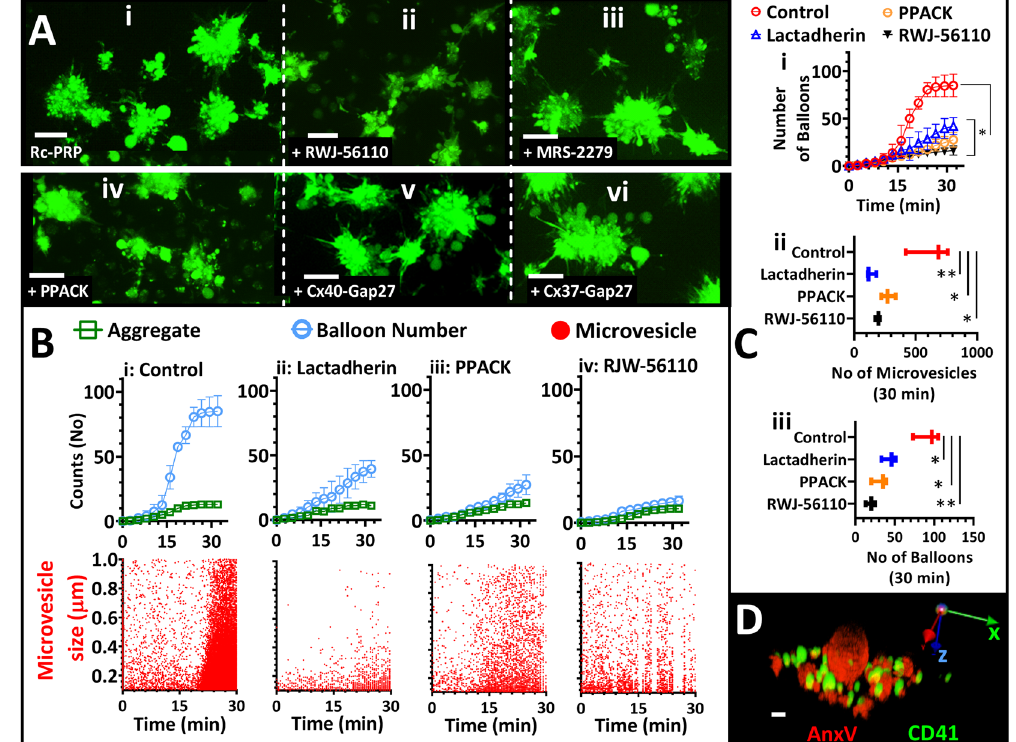
Figure 4. Thrombin-mediated synchronous ballooning is associated with a surge in microvesiculation. ( A ) Aggregate formation of Fluo-4-labelled platelets in re-calcified platelet-rich-plasma (Rc-PRP) in the absence (A-i) or presence of RWJ-56110 (A-ii), MRS-2279 (A-iii), PPACK (A-iv), Connexin40 inhibitor (A-v) or Connexin37 inhibitor (A-vi). Images shown at 1 hr. ( B ) Platelets in Rc-PRP adhering to a collagen-coated surface were monitored for microvesicle release in real time by image-based particle counting. Microvesicles were AnnexinV + and between 100 nm and 1 µ m diameter. Display shows scatter plot in the absence (i) or presence of lactadherin (1% v / v , ii), PPACK (100 µ M, iii) and RWJ-56110 (50 µ M, iv). Upper panel B shows corresponding charts of the real time formation of aggregates and the appearance of balloons in the field of view. ( C ) C-i, shows the pooled plot of balloon formation against time data in B (upper panel). C-ii and C-iii show total number of microvesicles (C-ii) and number of balloons (C-iii) at endpoint (30 min) plotted against treatment. ( D ) 3D image of platelet-derived microvesicles stained with Alexa488-conjugated anti-CD41 antibody (green) and Alexa568-Annexin-V (red) show that platelets in Rc-PRP release a mixed microvesicle population. Data analysis was by Friedman test, followed by Dunn’s multiple comparison test. * P < 0.0 5 was considered significant. Scale bar represents 5 µ m (A) and 1 µ m (D). Cii and Ciii show interleaved box plots with whiskers showing minimum to maximum values, median, and interquartile range. Data were from 10–15 aggregates (of 7–40 platelets) per view; and 35 ± 5 aggregates were analysed for each of 5 donor blood